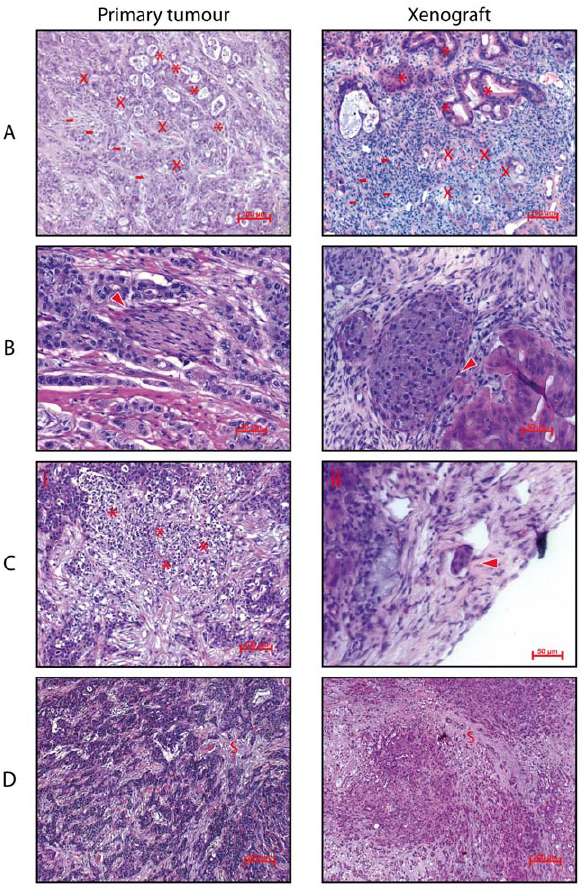
Figure 6. Histological comparison of primary and xenograft tumours. Shown here are H&E stains of primary and xenograft tumours. A. Primary and xenograft tumours show similar differentiation phenotypes ranging from overall poor differentiation ( 2 ) over micropapillary growth (x) to more differentiated ductular formations (*). B. Perineuronal invasion can be observed in both primary and xenograft tumours (arrow heads). C. Shown here are areas of tumour necrosis, demarcated by neutrophil granulocytes (C i, asterisks) and tumour infiltration of lymphatic vessel (C ii, arrow head). D. Distribution of stroma (S) in primary and xenograft tumour tissue. Tumour cells of both specimens are embedded in desmoplastic tumour stroma. While stroma in the primary tumour is dispersed throughout the tumour, it is more localized in the xenograft.